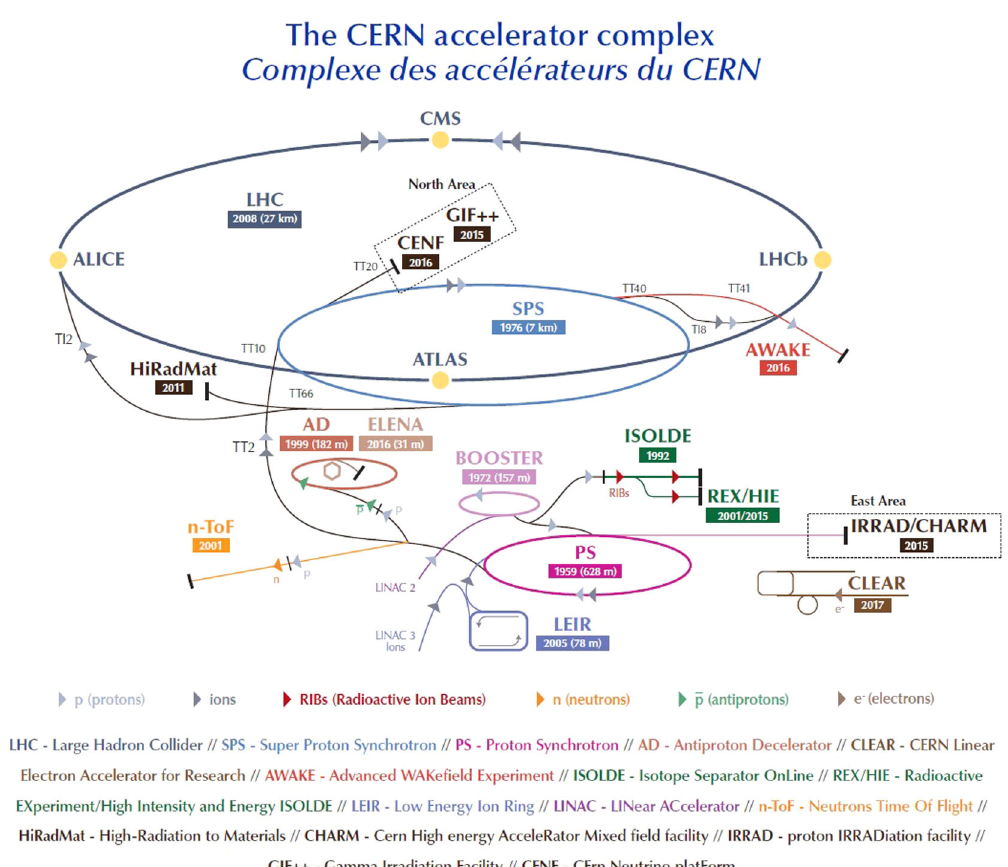
FIG. 2. Schematic of CERN accelerator